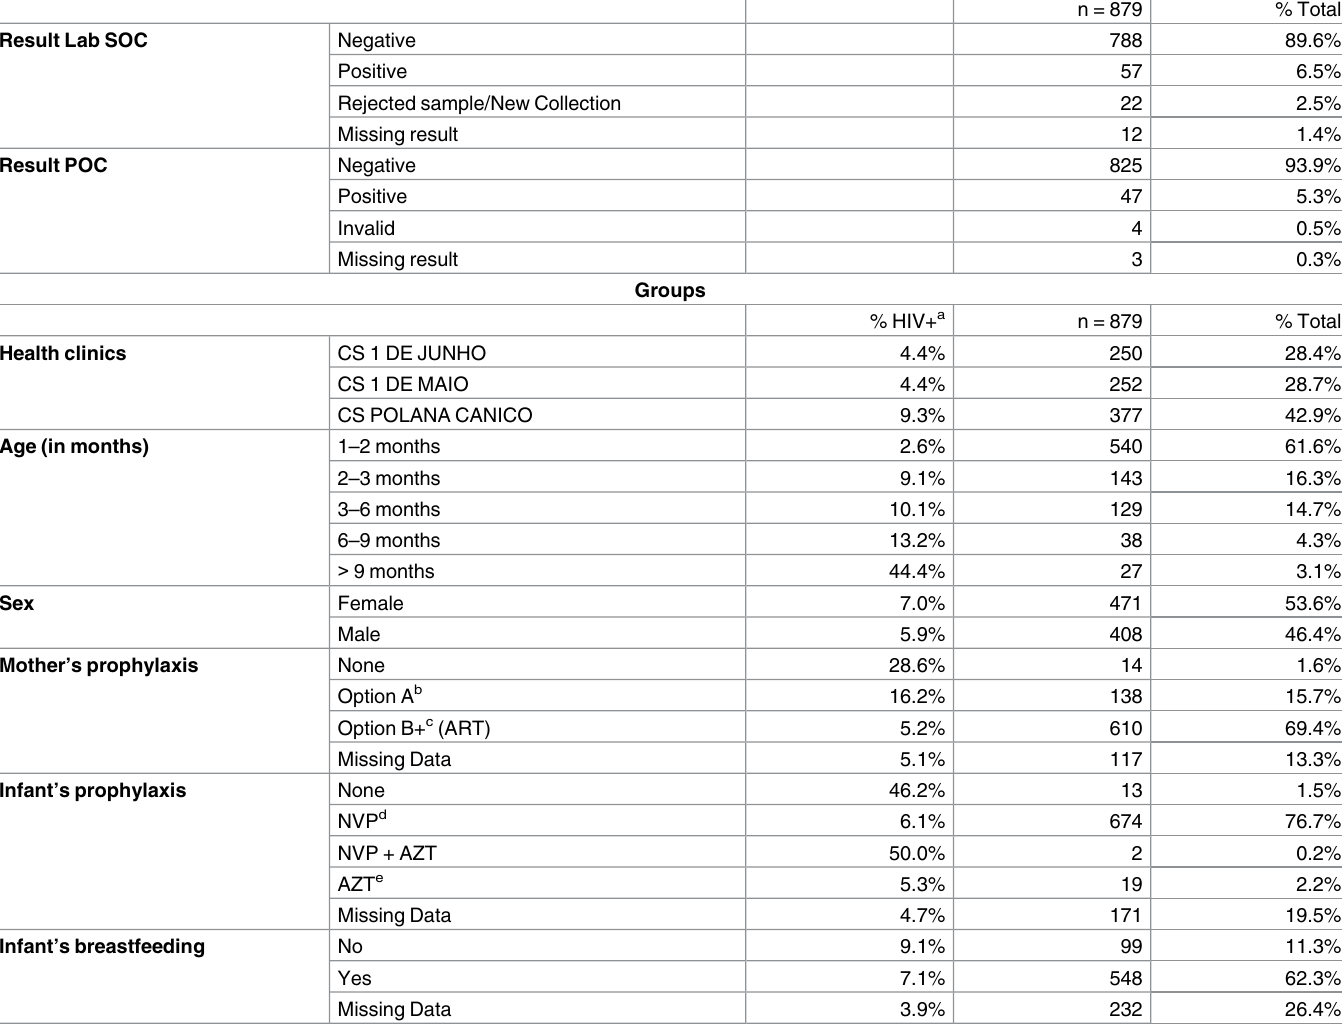
Table 1. Demographic and Clinical Characteristics of Mother—Infant Pair Study